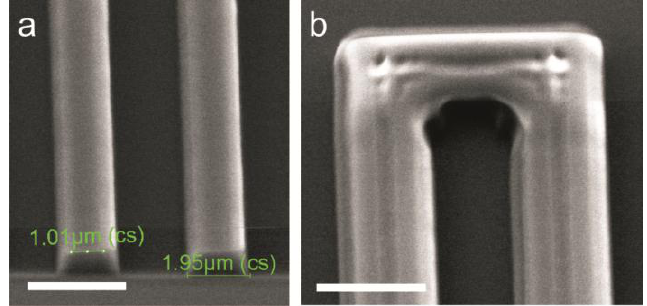
Figure 4. SEM images (at 30° tilt) of the resist structure. ( a ) The 2 µm structures (resist lines represent the area between the electrodes), showing an almost 2 fold difference in the width of the top and bottom layer of the resist, with a narrower top part. The scalebar is 3 µm; ( b ) The resist structure at the end of an electrode, showing an inhomogeneous surface topography with a central groove. The electrode (dark region in between the light regions) is also ill-defined at the corner. The scale bar is 5 µm.